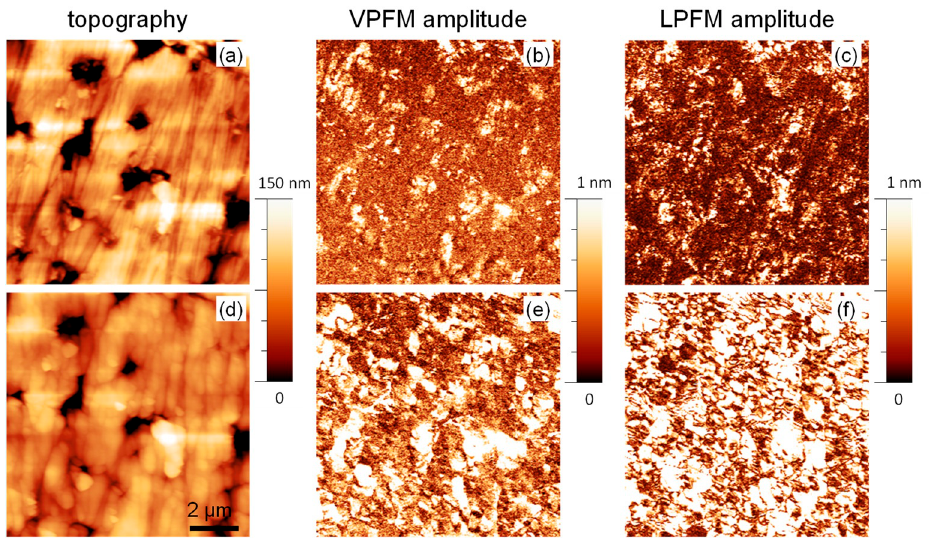
Figure 8. Topography ( a , d ), vertical PFM amplitude ( b , e ), and lateral PFM amplitude ( c , f ) images of the 0.35BMT–0.65BZT ceramics before ( a – c ) and after annealing ( d – f ).